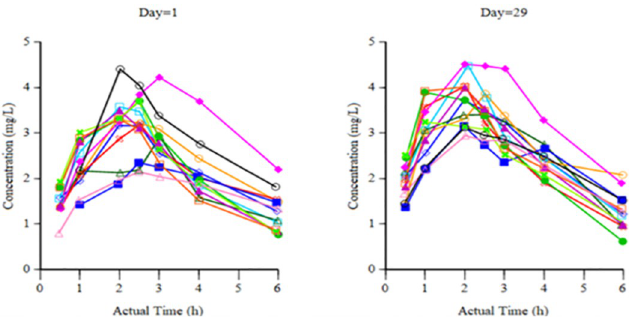
Fig 2. Post-injection plasma ILB 1 levels for individual patients at Day 1 and Day 29.